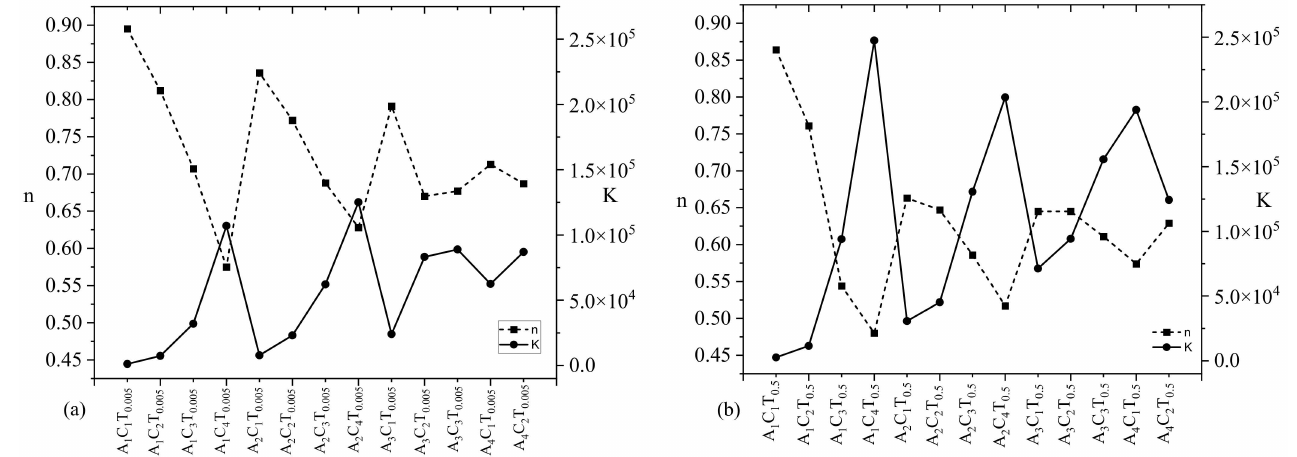
Figure 4. Shear thinning factors ( n and K ) of compositions composed with various percentages of alginate (1–4%) and CMC (1–4%) with a constant percentage ( a ) 0.005% and ( b ) 0.5% of TO-NFC. All n values less than 1 confirm a shear thinning behavior of all